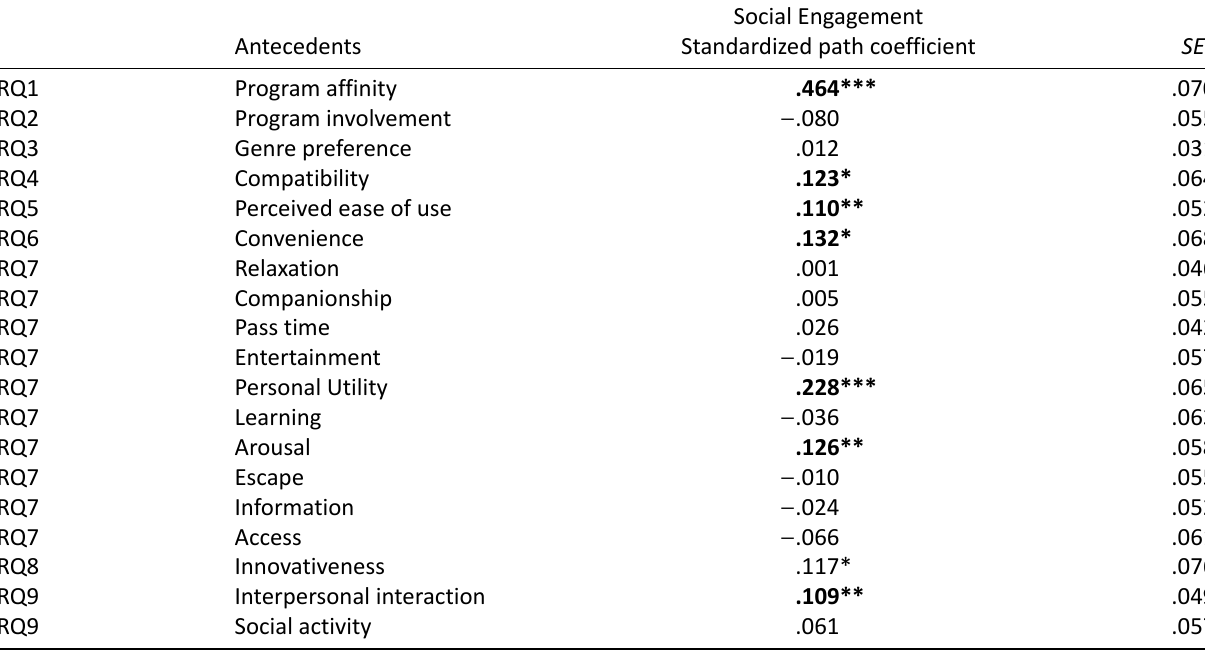
Table 2. Antecedents to social television viewing via second-screen platforms.